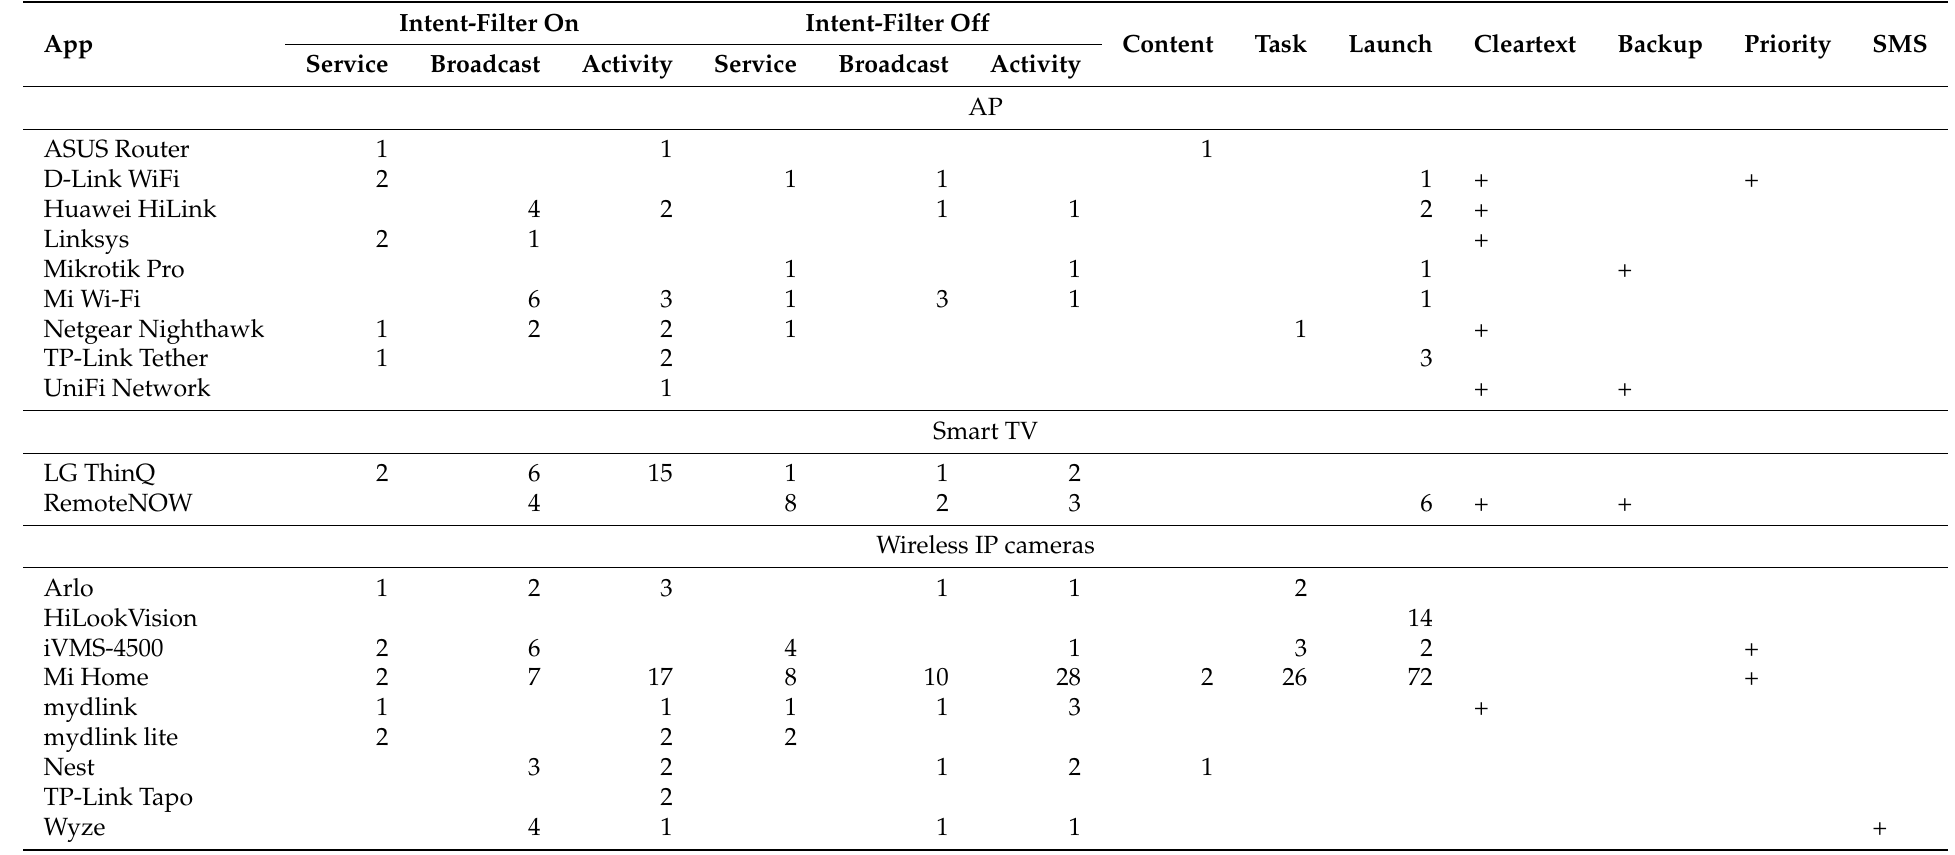
Table 4. List of identified potential issues in the manifest file of each